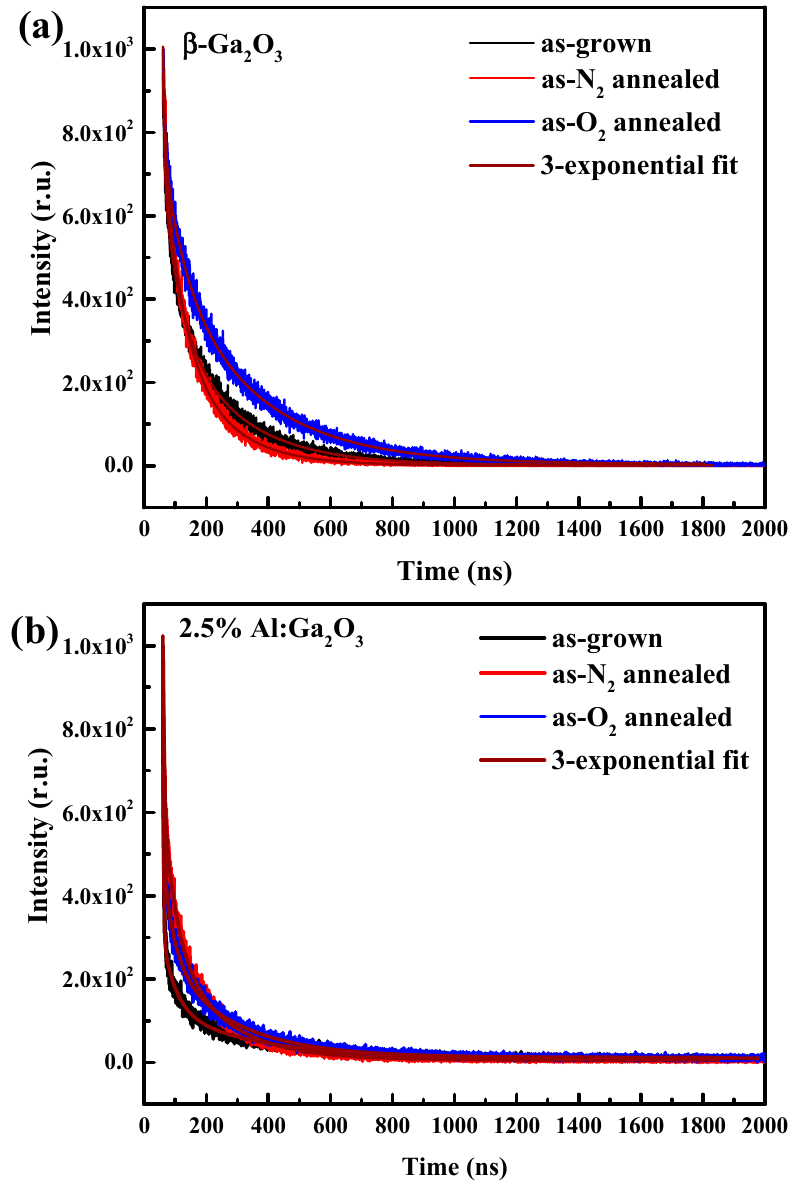
Figure 4. PL decay profiles of ( a ) undoped β -Ga 2 O 3 and ( b ) 2.5 mole% Al-doped β -Ga 2 O 3 crystal. (Ex. 270 nm, Em. 380 nm).